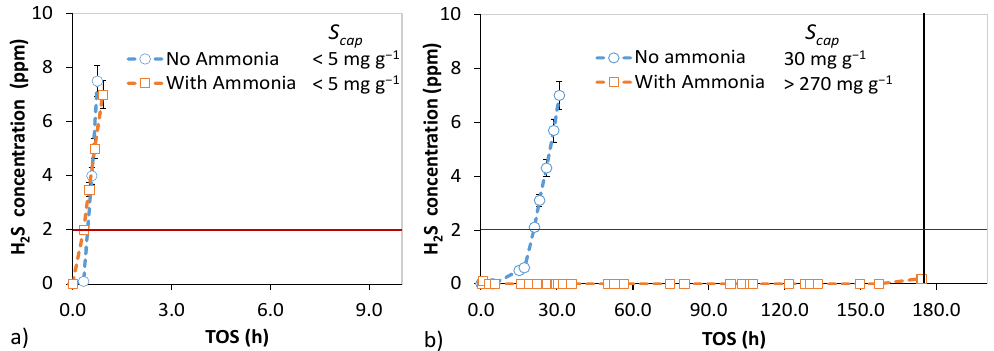
Figure 5. Effect of 35 ppm ammonia in syngas for H 2 S removal using AC1 at 50 °C. Syngas O 2 concentration was 3000 ppm and RH was 50%. ( a ) SV 16,000 h −1 (reactor 1) and H 2 S concentration 70 ppm. ( b ) SV 3700 h −1 (reactor 2) and H 2 S concentration 140 ppm. Particle size distribution—0.5–0.85 mm.